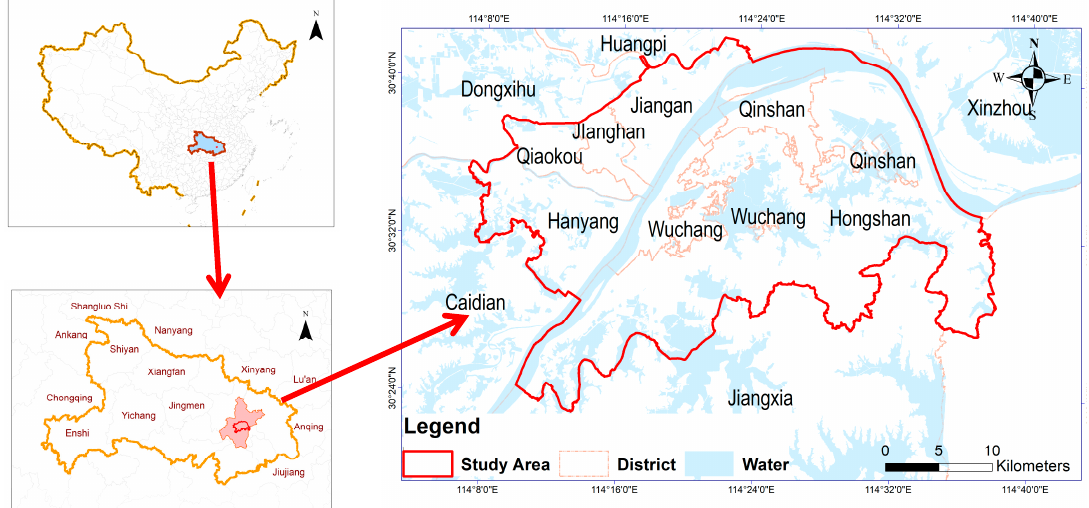
Figure 1. The study area comprises the downtown districts of Wuhan, Hubei Province, China, including the Jiang’an, Jianghan, Qiaokou, Hanyang, Wuchang, Hongshan, and Qingshan Districts. The world’s third longest river, the Yangtze River, and its tributary, the Hangjiang River, meet in the center of Wuhan. They divide the city into three parts: Wuchang, Hankou, and Hanyang. Wuhan is a typical city facing severe flood and waterlogging threats due to the fact that the terrain is